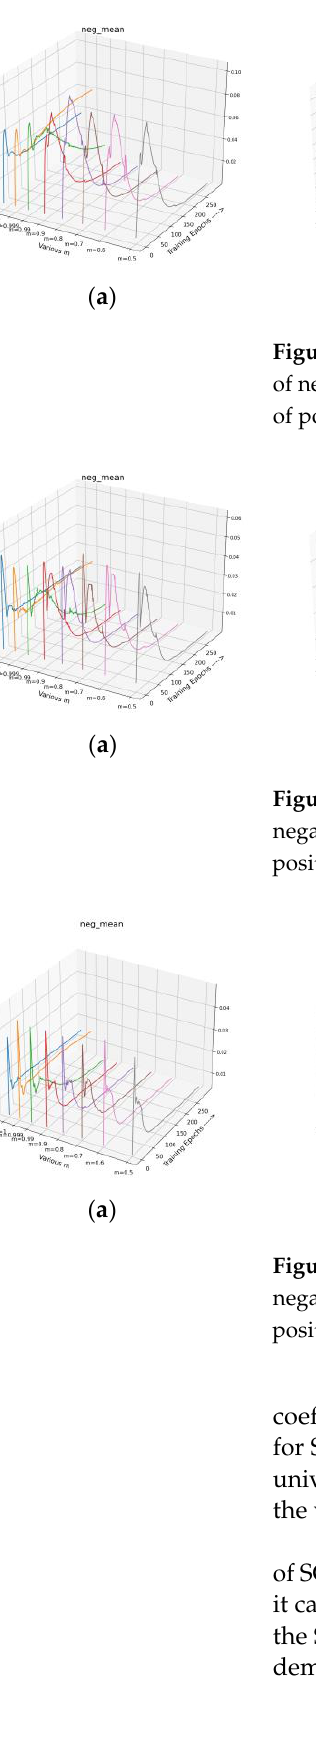
of positive similarity. Different colors corresponds to different values of 𝑚 .